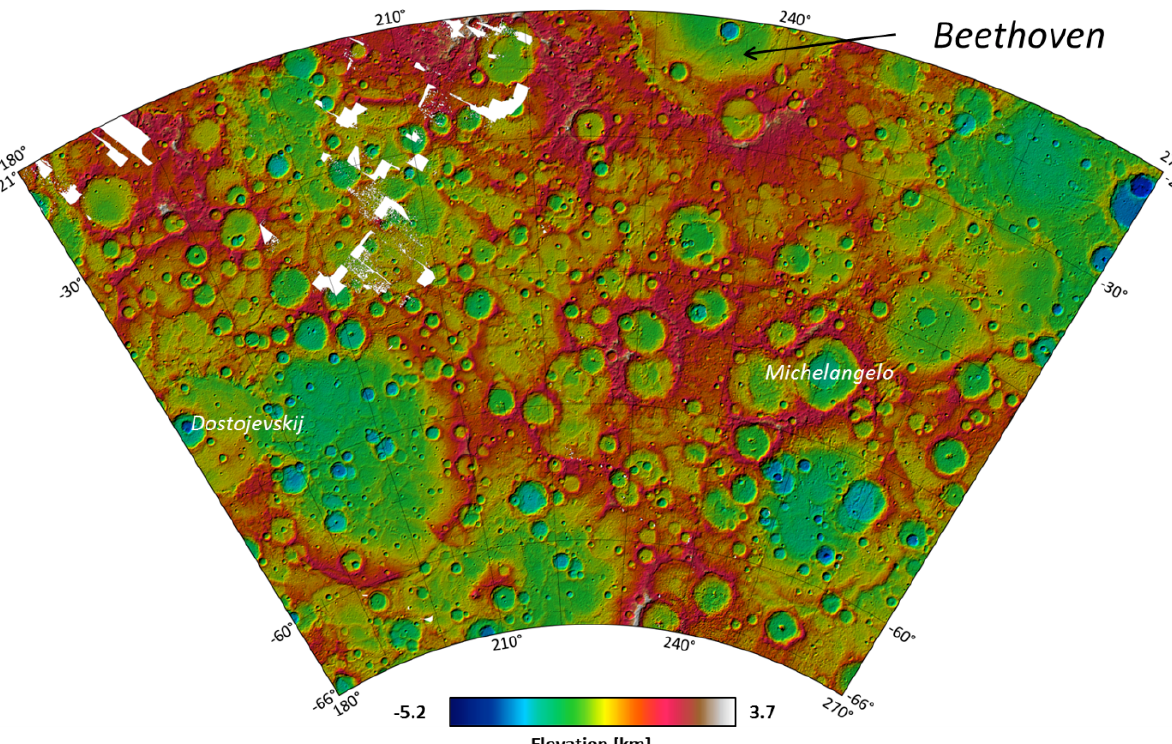
Figure 3: H12 “Michelangelo” quadrangle